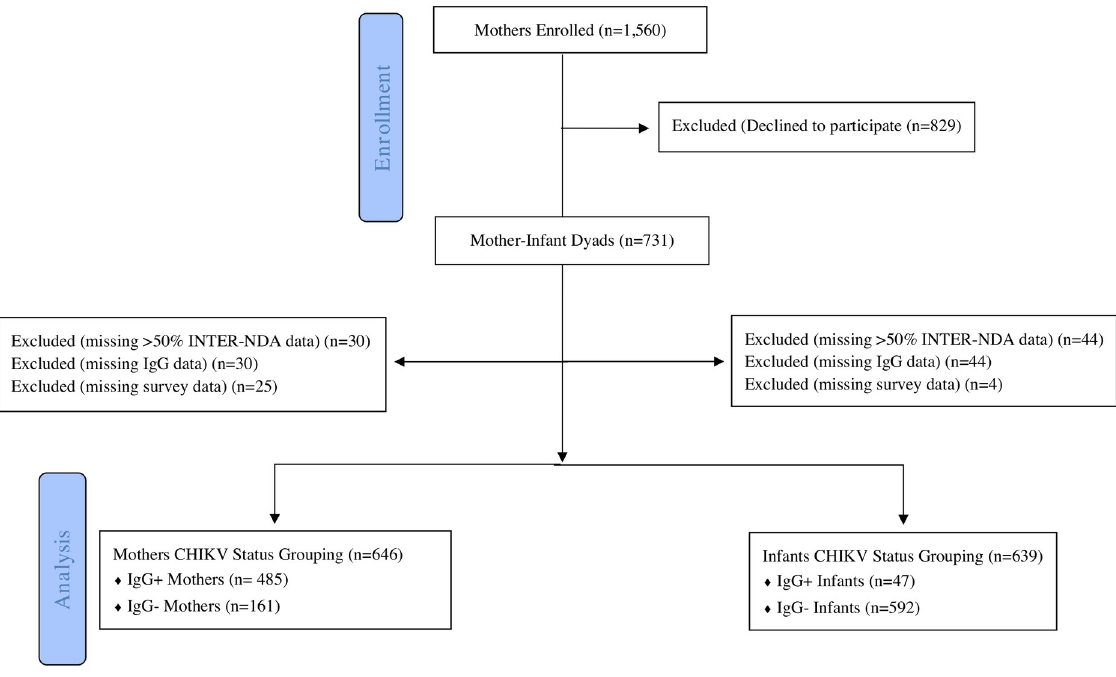
Fig 2. Flow chart of participant breakdown.